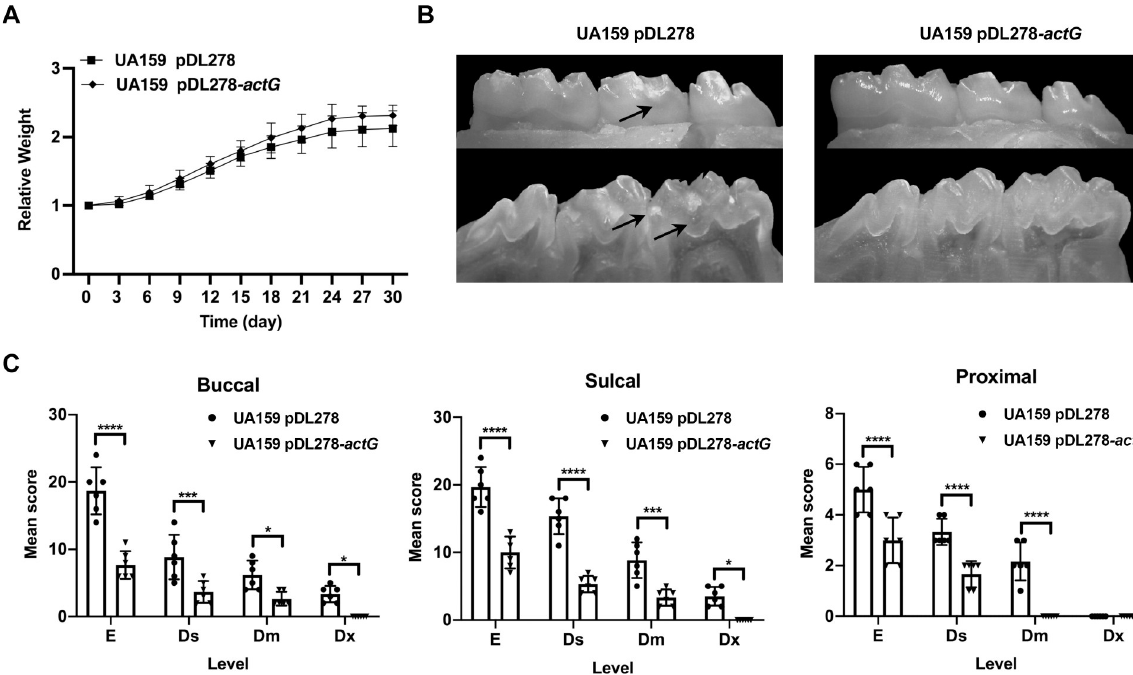
Fig 8. Effect of actG on the cariogenicity of S . mutans in rats. (A) The rats were weighed every three days until the termination of the experiment. (B) The representative images of the buccal (above panel) and sulcal (below panel) of the mandible with molars were displayed. The arrows indicate the representative carious lesions. (C) A statistic chart of the Keyes’ score was shown in Table 1. Each plot represents the caries score of each rat (n = 6) on buccal, sulcal, and proximal surfaces, respectively. The severity of carious lesions is classified into four kinds: enamel only (E), slight dentinal (Ds), moderate dentinal (Dm), and extensive dentinal (Dx). Results are presented as mean ± SD ( � P < 0.05, �� P < 0.01, ��� P < 0.001 or ���� P < 0.0001).